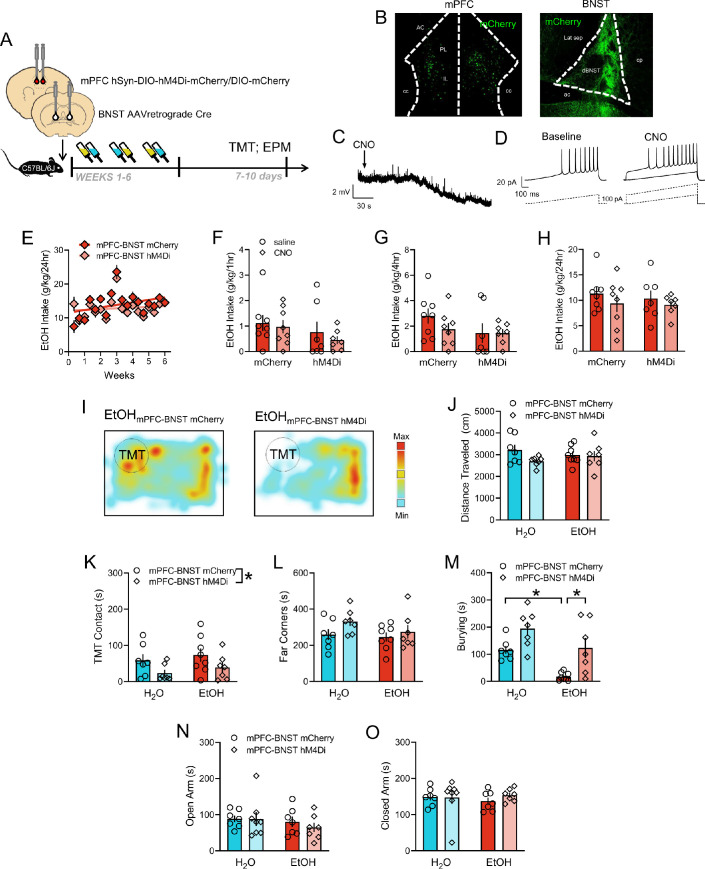
DREADD-mediated inhibition of mPFC-BNST pathway and assessment of EtOH drinking and TMT-related behaviors.(A) Time course of mPFC-BNST chemogenetic strategy in C57BL/6J mice before EtOH and TMT. (B) Images of AAV-hM4Di-mCherry expression in mPFC cell bodies, left, and BNST terminals, right (H2O mCherry n = 7, H2O hM4Di-mCherry n = 7. EtOH mCherry n = 8, EtOH hM4Di-mCherry n = 7). mCherry was enhanced with a GFP immunostain. Slice physiology validation of the DREADD strategy, in mPFC neurons, as represented by (C), hyperpolarization of resting membrane potential after CNO bath application. Inset scale bar indicates 2 mV height and 30 s time. (D) Latency to action potential threshold before and after CNO with 100 pA current ramp steps. Scale bar indicates 20 pA height and 100 ms time. (E) EtOH drinking (g/kg/24 hr) across 6 weeks with mPFC-BNST hM4Di (red) or mCherry (light red). EtOH intake (g/kg) across (F) 1 hr, (G) 4 hr, and (H) 24 hr after i.p. saline (circles) or 3 mg/kg CNO (diamonds). (I) Sample TMT heatmaps of EtOH mPFC-BNST mCherry (left) and EtOH mPFC-BNST hM4Di (right) mice. In the TMT test, (J) distance traveled (cm), (K) TMT contact, (L), far corners (sec), and (M), burying (sec). In the elevated plus maze, duration in the (N), open arms (sec), and (O), closed arms (sec). *p<0.05.